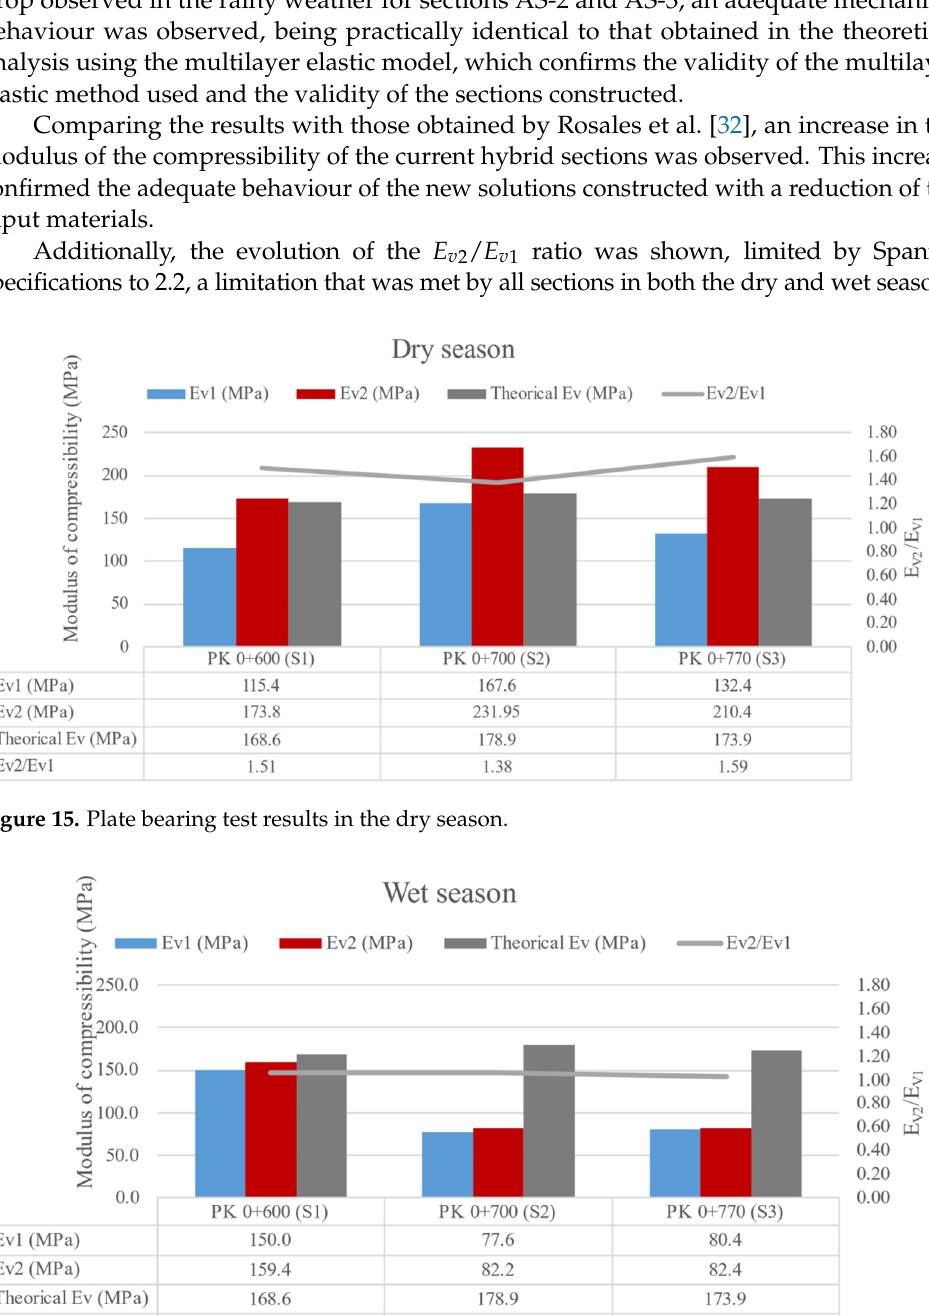
Figure 17. Annual average plate bearing test results. As is shown in Figure 15, all the sections presented a medium quality, which verified the adequate structural behaviour in relation to the volume of the loads the sections will support during their useful life. An improvement in the quality of subgrades AS-2 and AS-3 was observed due to the addition of nanomaterials, similar to that observed in the FDW results. Analysing Figure 16, a drop in the equivalent modulus was observed in all three sec- tions due to the rainy period; however, this drop was greater in sections AS-2 and AS-3 than AS-1. This sharp drop may be due to a lack of bearing capacity in some of the layers that make up the section because of the rain or perhaps a specific problem associated with the uncertainty of the plate loading test. Finally, Figure 17 shows the average annual behaviour of the sections. Despite the large drop observed in the rainy weather for sections AS-2 and AS-3, an adequate me- chanical behaviour was observed, being practically identical to that obtained in the theo- retical analysis using the multilayer elastic model, which confirms the validity of the mul- tilayer elastic method used and the validity of the sections constructed.